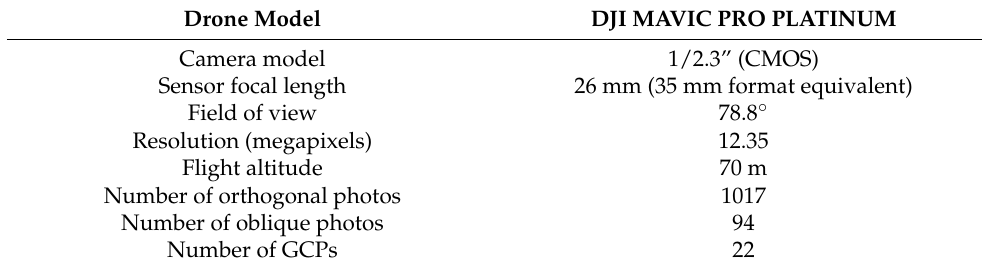
Figure 5. September 2019 flight path over the study area as seen in the screen capture from the DJI GO 4. Table 2. September and December 2019 flight parameters.